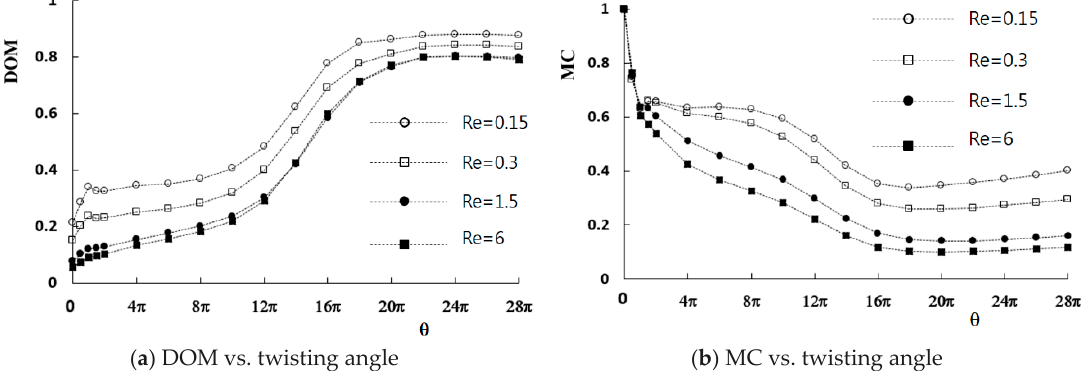
Figure 5. Variation of the DOM and MC (mixing cost) with the twist angle.